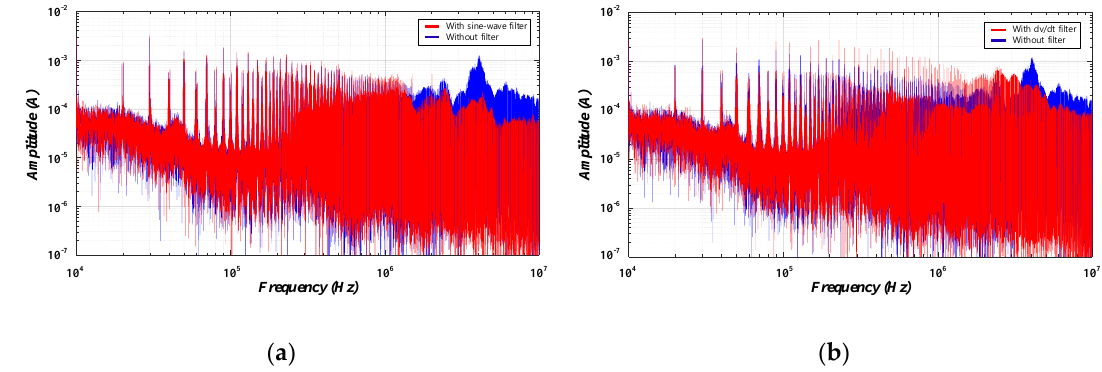
Figure 13. ( a ) Common mode current spectrum without or with sine-wave filter; and ( b ) Common mode current spectrum without or with dv/dt filter.